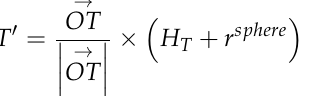
Table A2. Coefficients of the fitting model for Glonass system (Mean orbital height: 19,000 km). 𝒑 𝒂,𝒃,𝒄,𝒅𝜼 𝒑 𝟏𝑯 𝒑 𝟐𝑯 𝒑 𝟑𝑯 𝒑 𝟒𝑯 p η a , b , c , d 𝜂 𝑝 𝑎